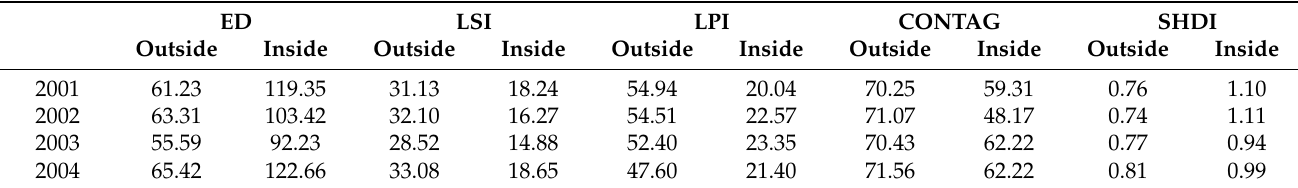
Table 2. Landscape pattern change in the L–S Creek watershed.